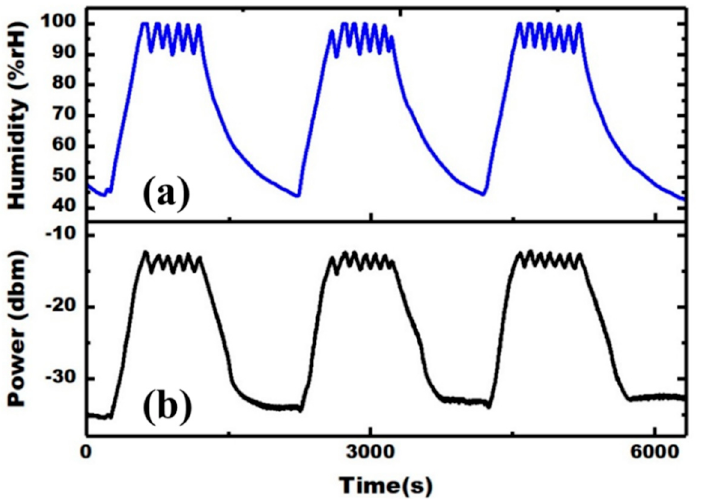
Figure 7. ( a ) Variation of RH in the chamber. ( b ) Variation of the transmitted power through the MF coated with SnS 2 .